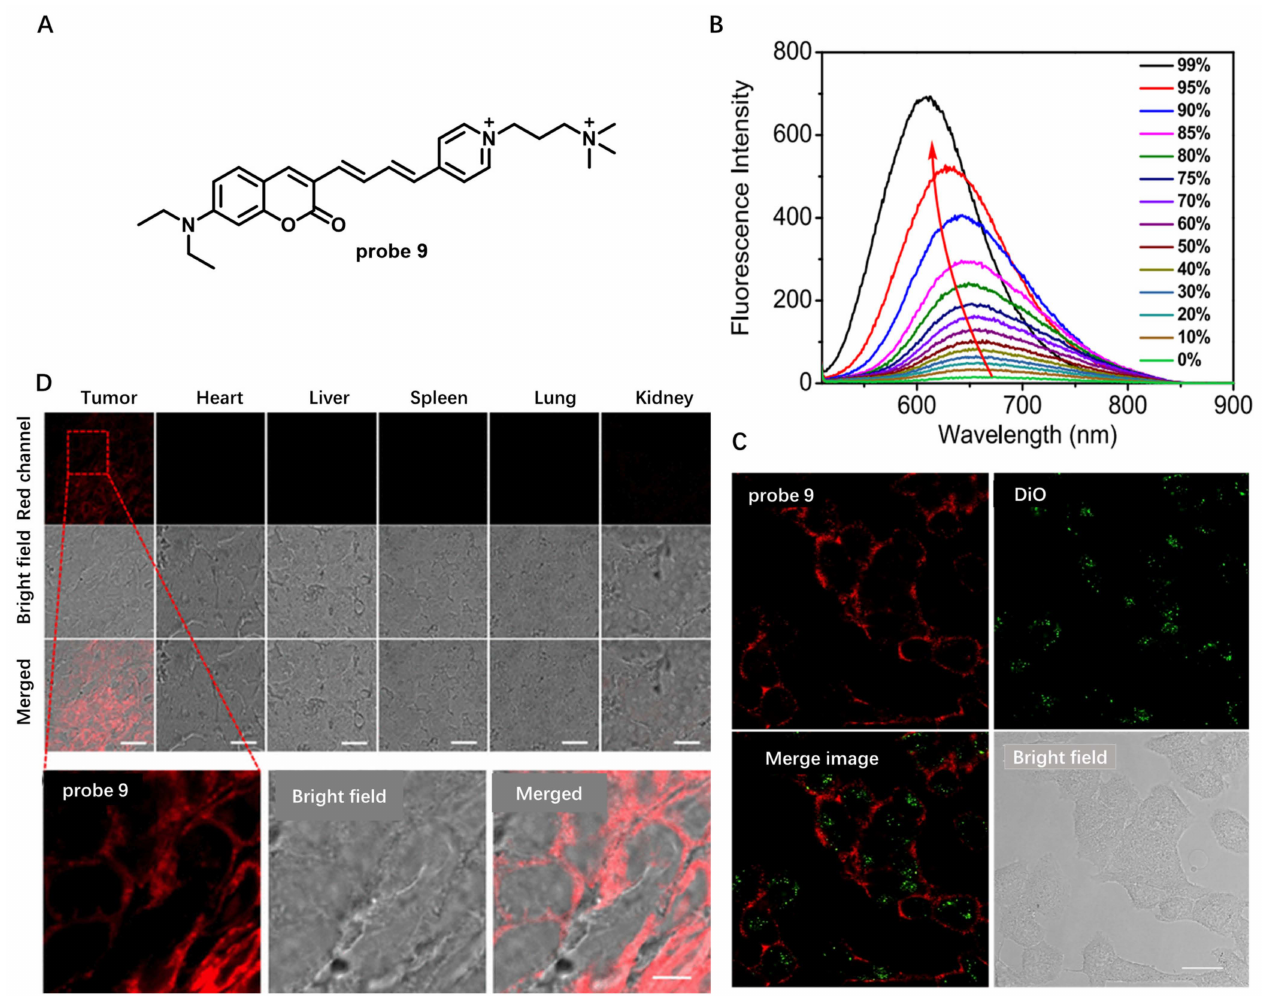
Figure 8. ( A ) Chemical structure of probe 9 . ( B ) Fluorescence spectra of probe 9 in water/1,4- dioxane solvent mixtures. ( C ) Long-term CM imaging using probe 9 . ( D ) Confocal images of tumor tissue and mouse organ tissue sections. Scale bar: 10 µ m. Copyright 2022 American Chemical Society